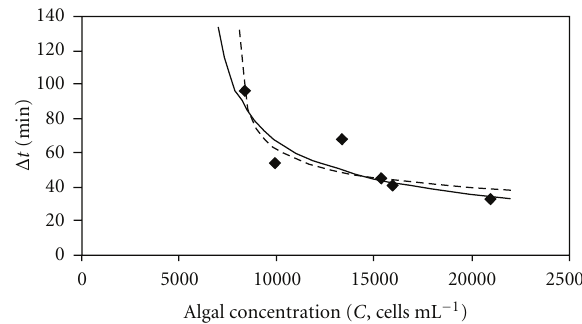
Figure 5: Mytilus edulis . Time before incipient saturation ( Δ t ) as a function of algal concentration ( C ) in steady-state experiments. Lines are asymptotic least square fits for Δ t = b/ ( C − C 0 ) a shown for C 0 = 8000 cells mL − 1 (dotted line) and for 5000 cellsmL − 1 (unbroken